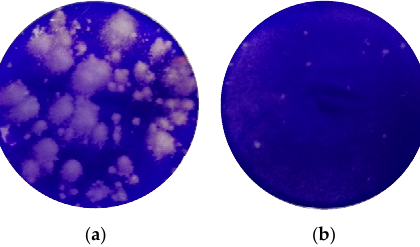
Figure 9. Curative plaque assay—H1-HeLa cell monolayer with plaques dyed with crystal violet: ( a ) H1-HeLa cells incubated with overlay medium containing 40% 2× Conc. EMEM for 72 h after infection with rhinovirus. ( b ) H1-HeLa cells incubated with overlay medium containing 40% isla Conc. 3 (0.077 g lozenge/mL) for 72 h after infection with a rhinovirus.